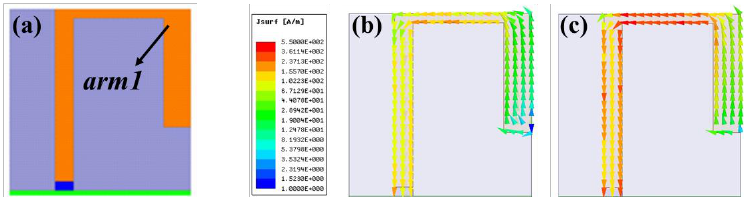
Figure 3. ( a ) The structure of arm1 and the surface current distribution of arm1 at ( b ) 2.45 GHz and ( c ) 3.68 GHz.